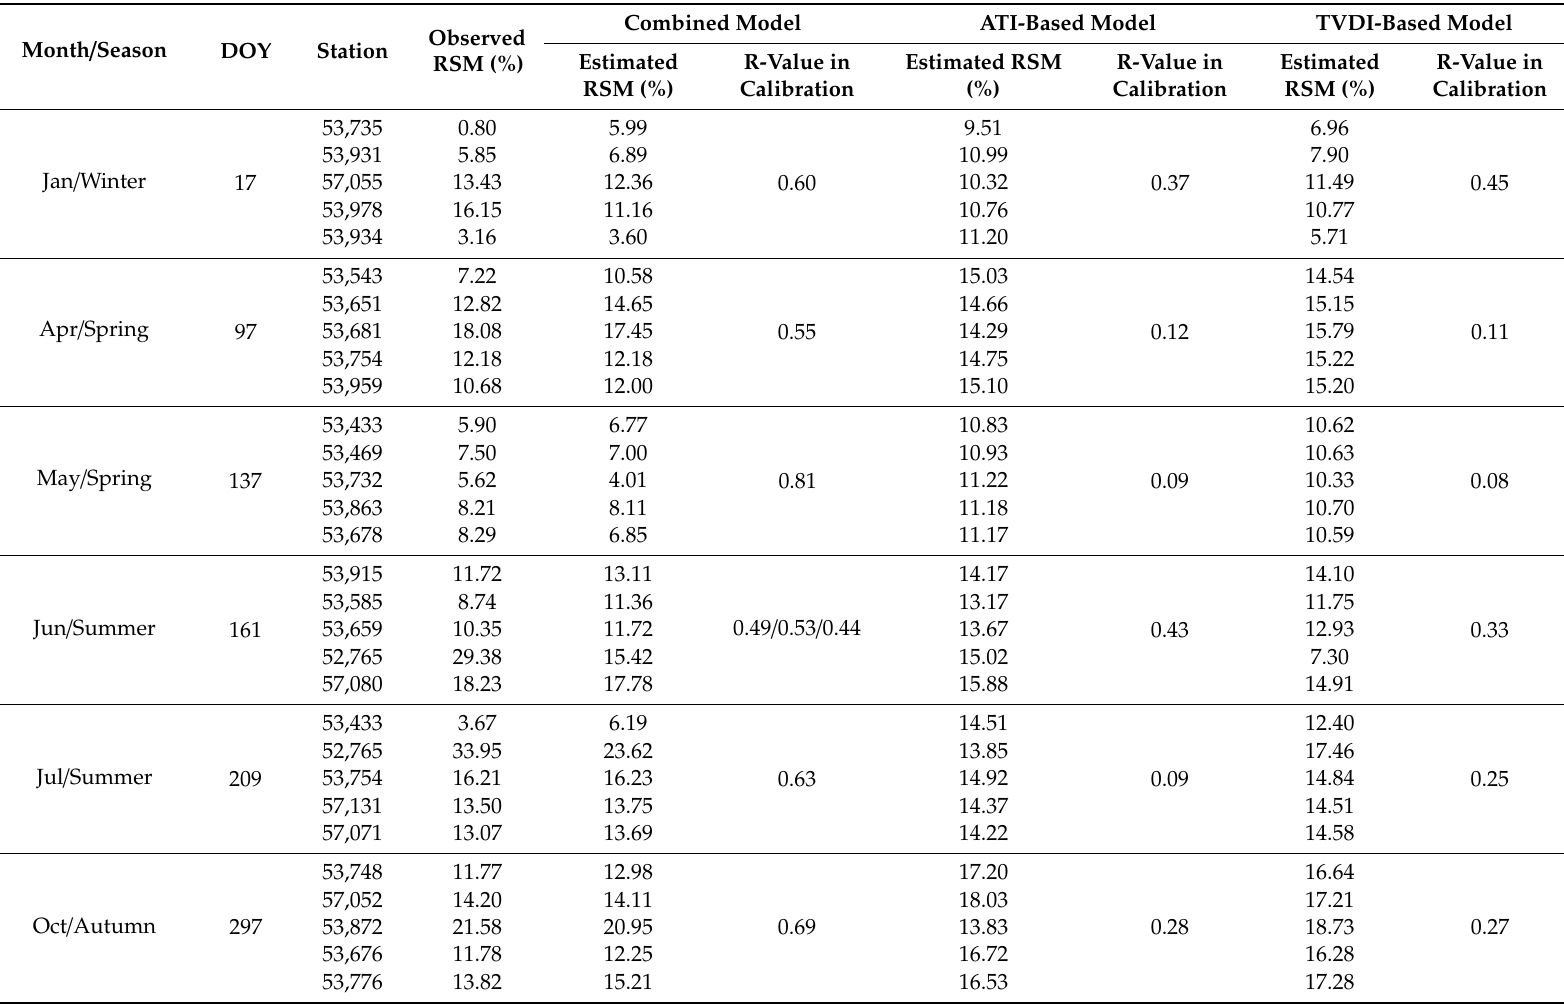
Table A4. Comparison of the estimated RSM and R-value in calibration using di ff erent models at some stations on DOYs 17, 353 (in winter), 97, 137 (spring), 161, 209 (summer), 297, and 329